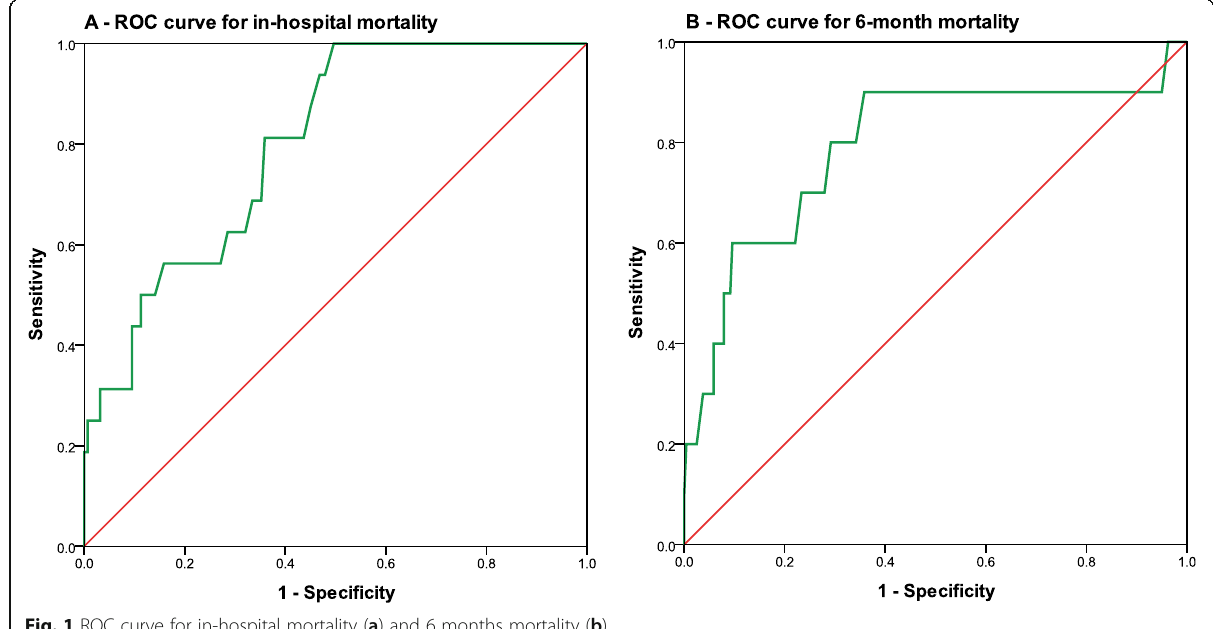
Fig. 1 ROC curve for in-hospital mortality ( a ) and 6 months mortality ( b